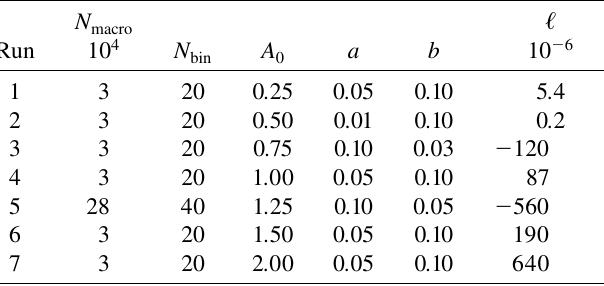
TABLE I. Simulation parameters for Fig. 15. The number of macroparticles used in the simulation is denoted by N N is the number of statistically independent longitudinal bins bin used for the coherent force